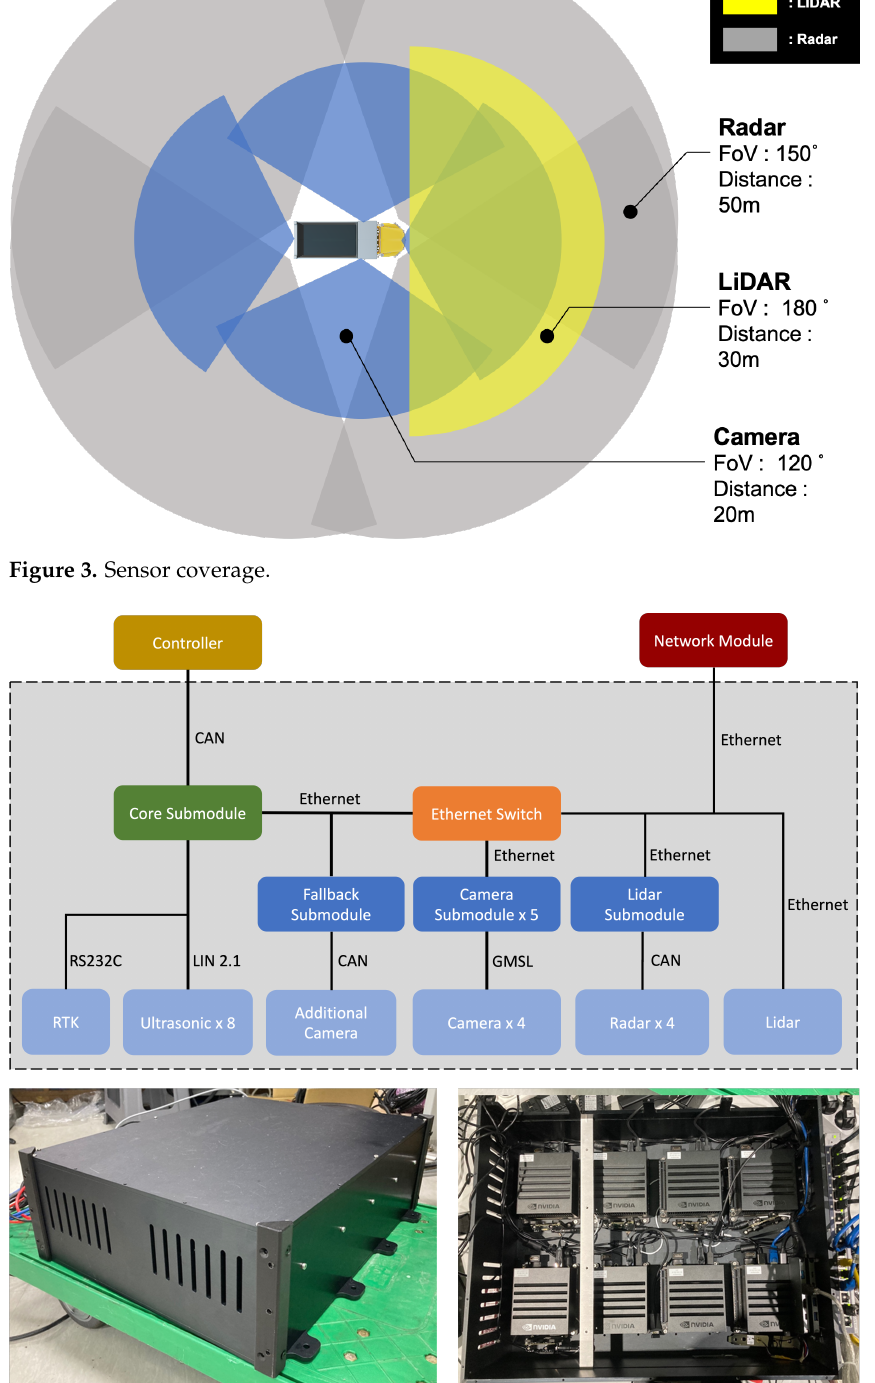
Figure 4. Modulebox structure and actual